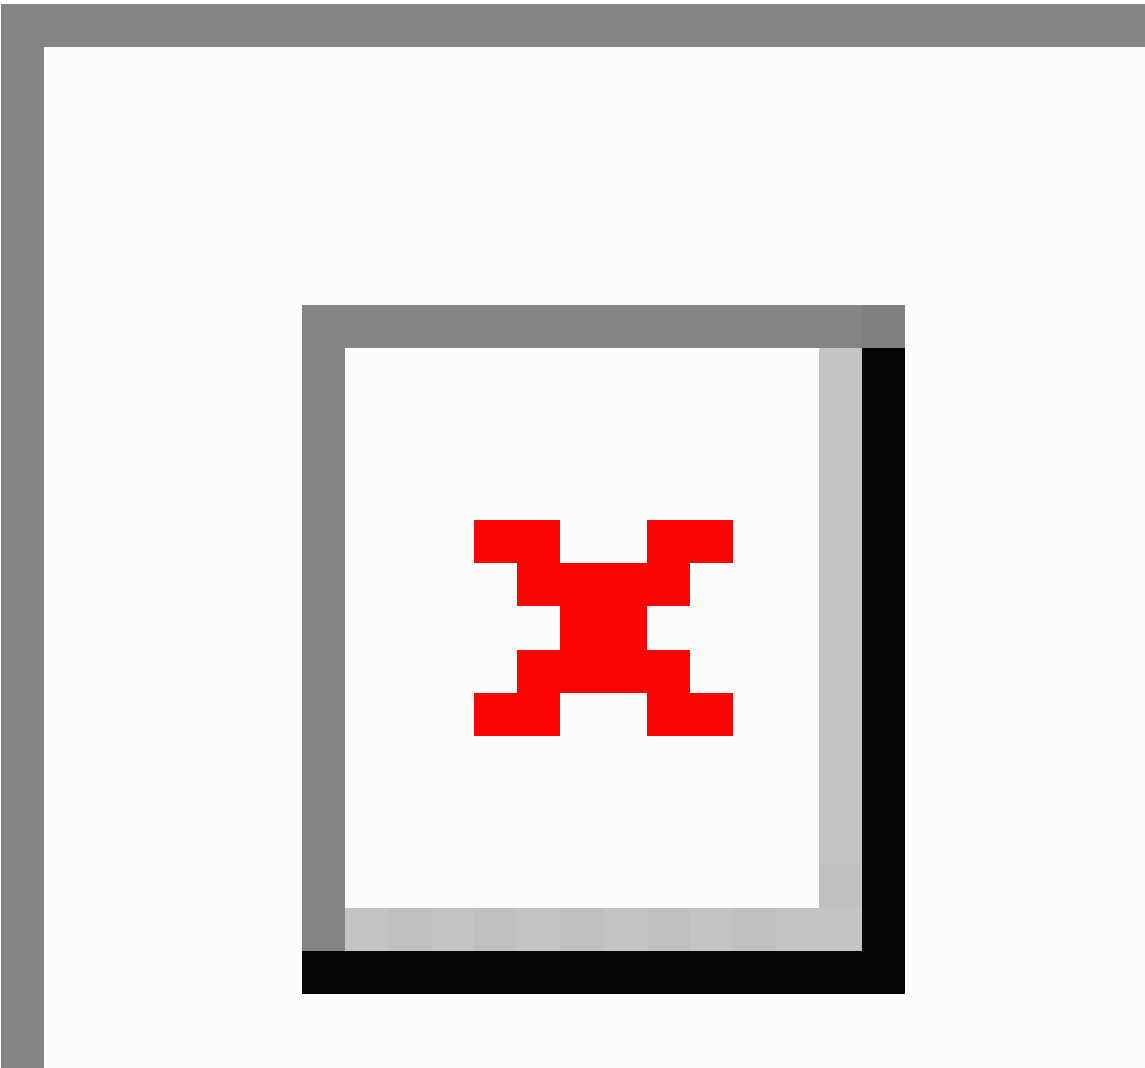
Figure 2. Attrition flow from the initial recruitment phase. G1 = static-only study group; G2 = interactive-only study group; G3 = full application study